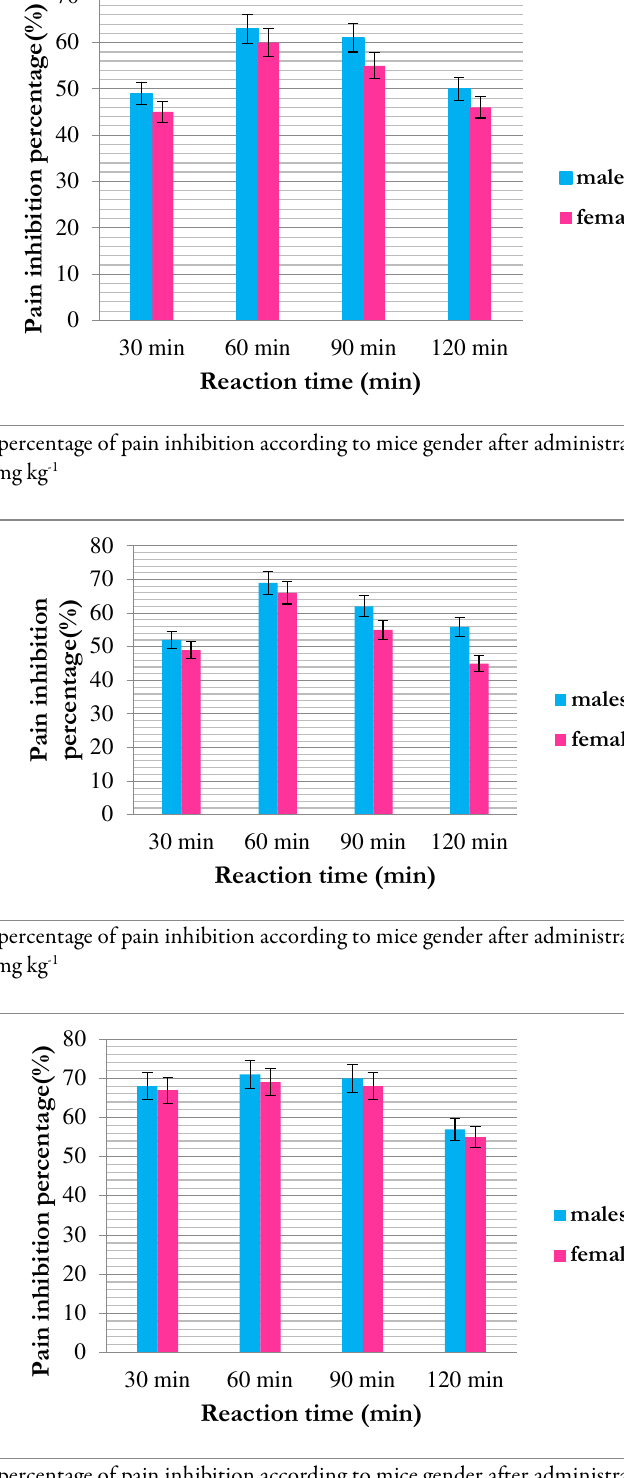
Figure 3. Figure 3.Figure 3. Figure 3. The percentage of pain inhibition according to mice gender after administration of the aqueous extract at 1,000 mg kg